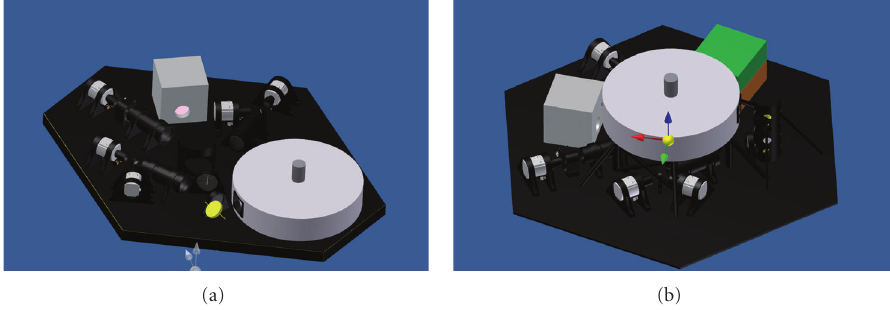
Figure 7: The other di ff erent Focal Plane Instrument Configurations.